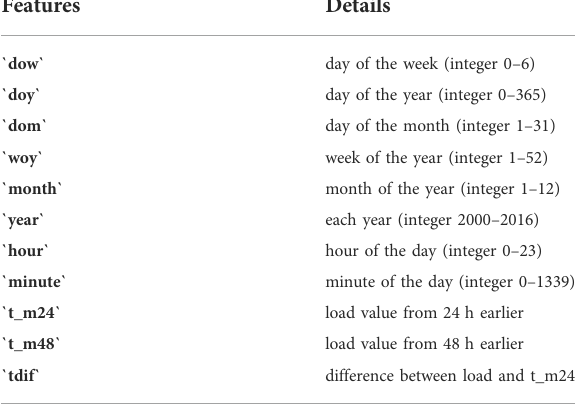
TABLE 3 Time series feature